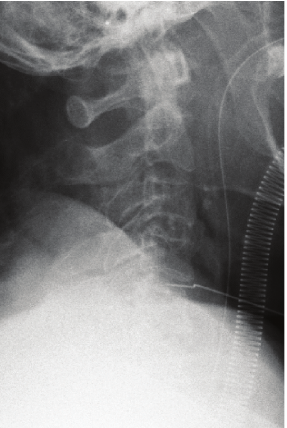
Figure 3: The second intraoperative radiogram after decompres- sion, bone grafting and temporally plate fixation. It appears to show that the plate bridges the C5 and C6